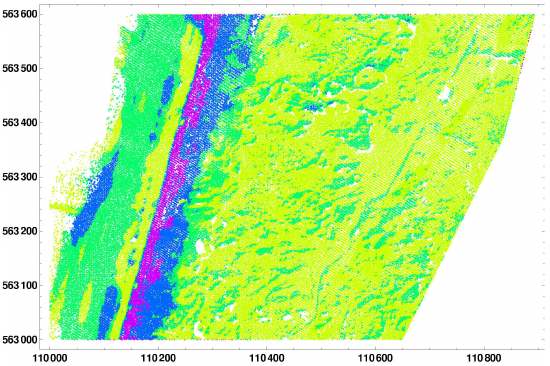
Figure 7. Clusters resulting from second run on the same ALS-TEXEL input data. Results differ from those shown in Figure 5 because the clustering started from a different random